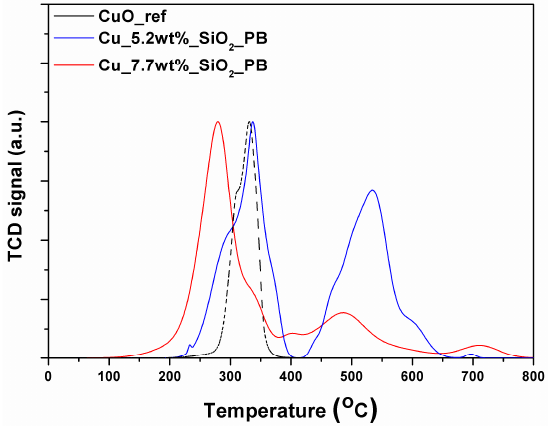
Figure 3. Temperature programmed reduction (TPR) profiles of samples Cu_5.2 wt %_SiO 2 _PB (blue line), Cu_7.7 wt %_SiO 2 _PB (red line) and CuO reference (black line).